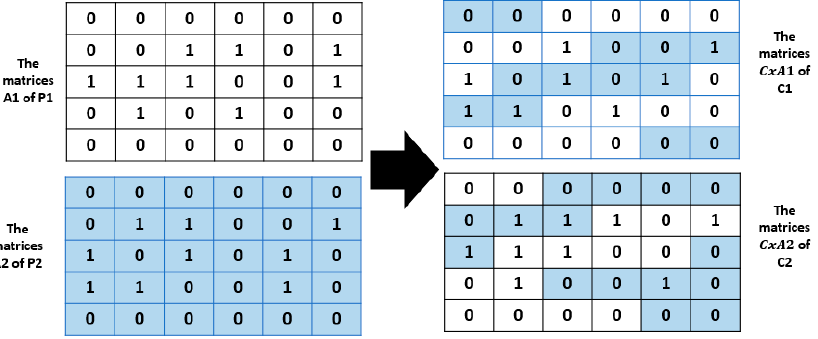
Figure 10. Example of the first type of crossover procedure.